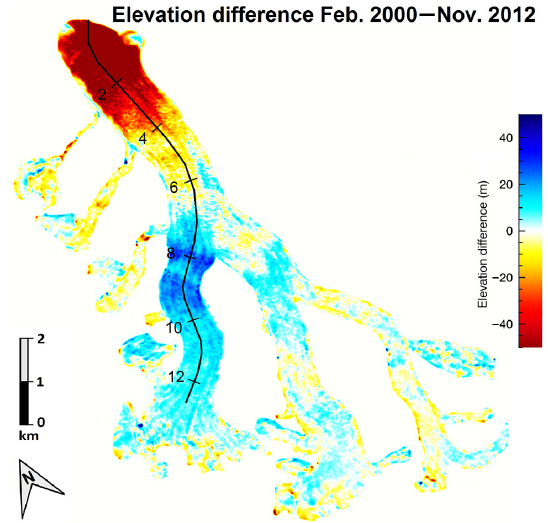
Figure 9. Glacier surface elevation changes between February 2000 (SRTM) and November 2012 (TanDEM-X). The elevation change represents 12 years of quiescence preceding the surge. The image is shown in radar coordinates for TanDEM-X data of orbit 75D, accounting for the slightly different orientation to the optical image in Fig. 3.